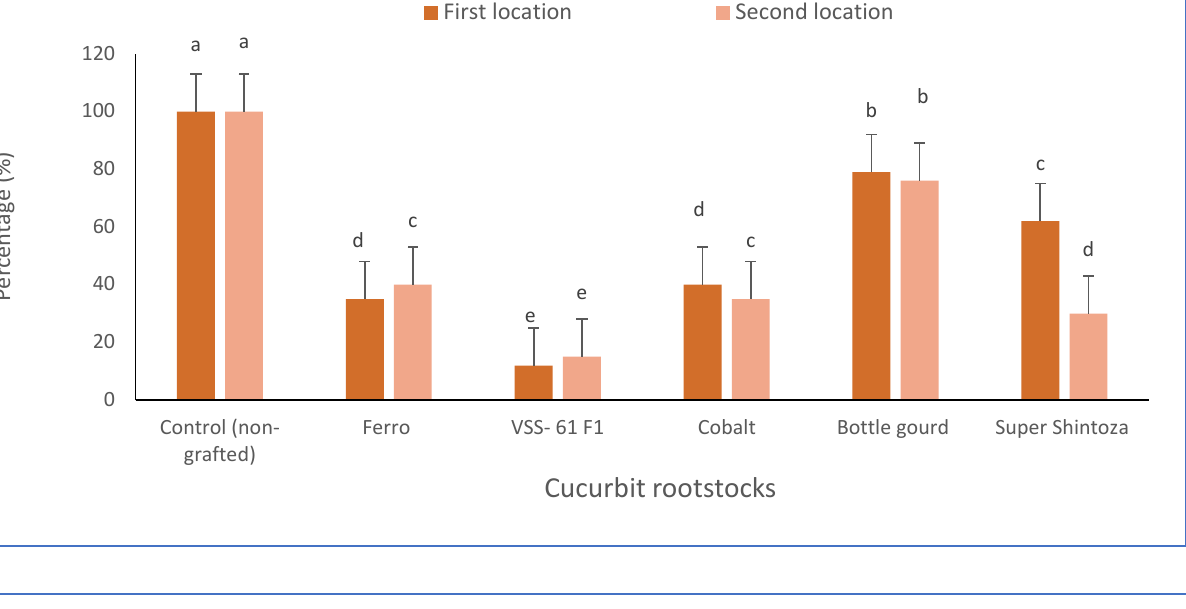
Disease severity (%)